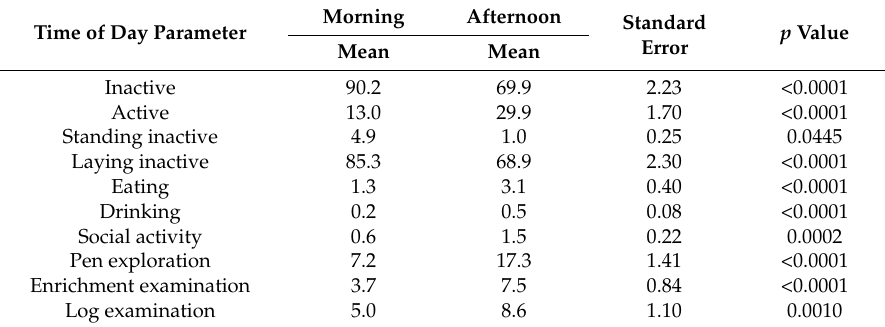
Table 7. Behavioural observation by time of day